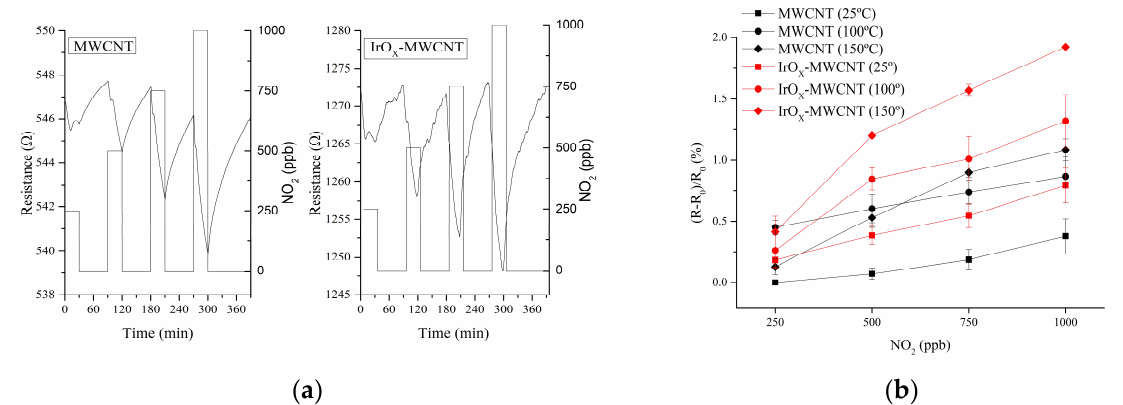
Figure 5. Typical response and recovery of the resistance signals when the sensors are exposed to different concentrations of NO 2 ( a ). Calibration curves obtained for NO 2 for bare carbon nanotubes and IrO X -MWCNTs at different operating temperatures under dry conditions. Error bars are standard deviations of responses ( b ).